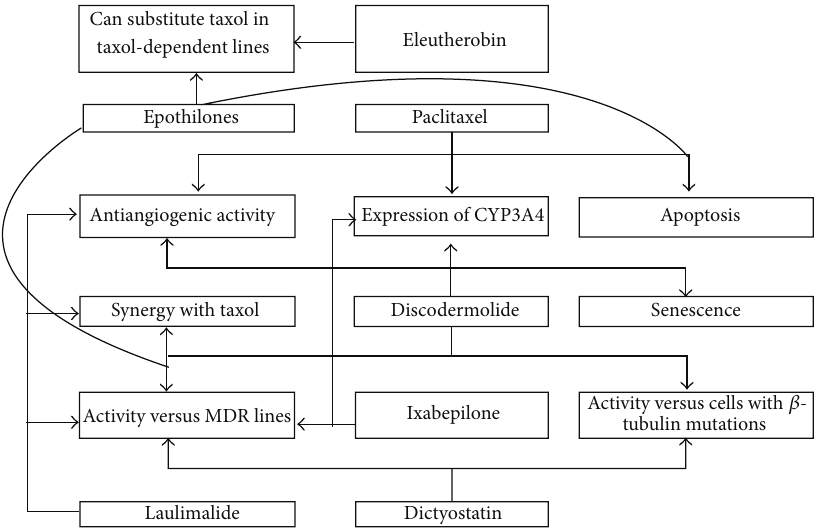
Figure 5: Similarities and differences between mechanisms of action and activity of microtubule-stabilizing